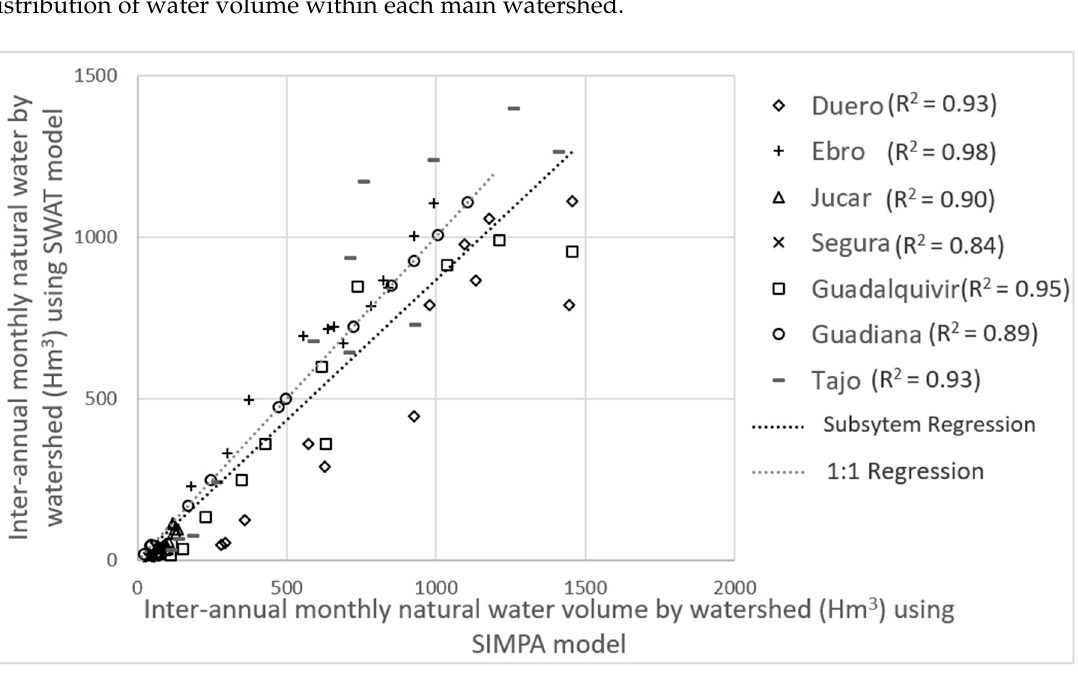
Figure 7. “Natural” water volume for subsystem simulated with SWAT (AC; additional calibration) versus “natural” water volume simulated with SIMPA (Figure 1B) of the main Spanish watersheds (inter-annual averages from 2000 to 2010).